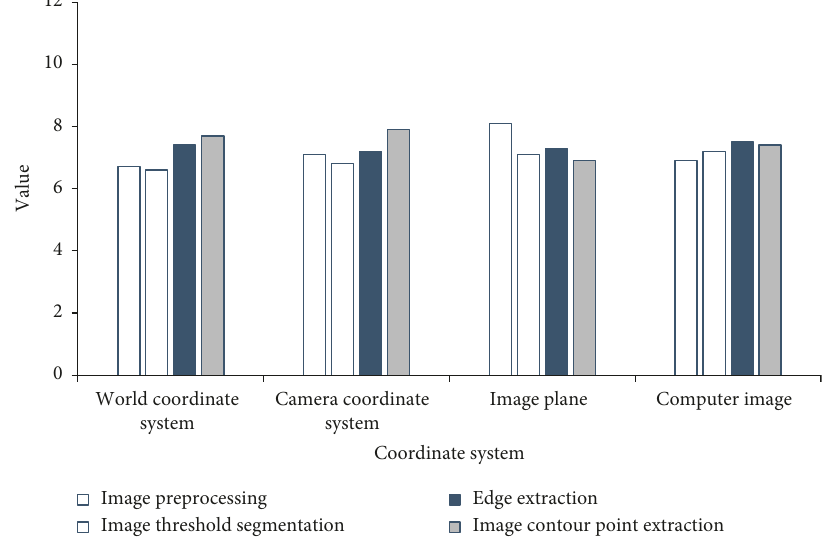
Figure 3: Different coordinate system attribute values.